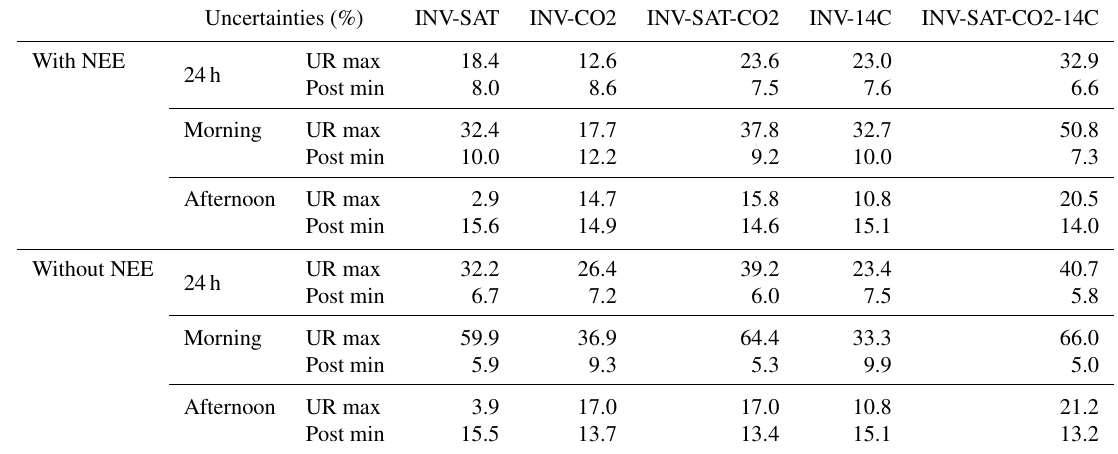
Table 7. Best score statistics of the uncertainty reductions (UR max for the highest UR) and the posterior uncertainty (Post min for the smallest posterior uncertainty) in inversions with and without NEE, for regional 24h, morning, and afternoon FF emission regional budgets. In the main area of interest, these budgets combine emissions from urban areas, large plants, and the more diffuse regional sources. Uncertainties (%) INV-SAT INV-CO2 INV-SAT-CO2 INV-14C INV-SAT-CO2-14C With NEE UR 24h